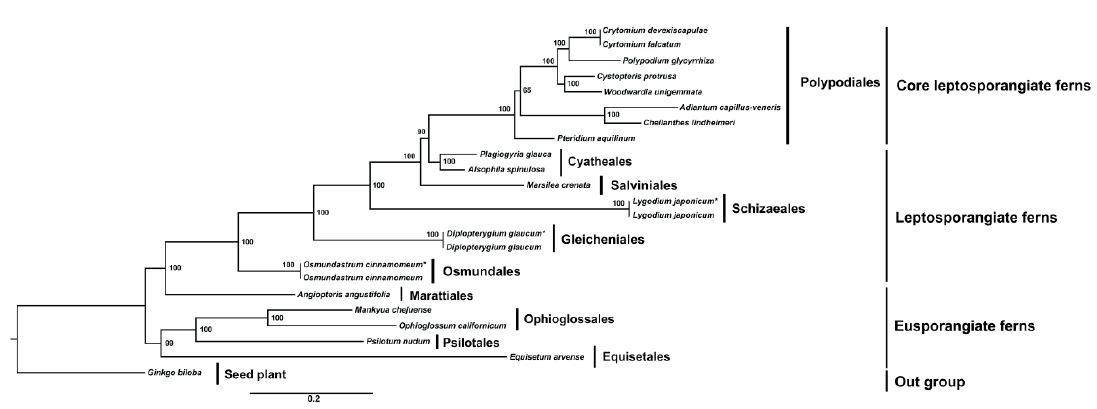
Figure 8. Molecular phylogenetic tree of 23 distinct fern taxa based on 76 protein-coding genes in the cp genome. The tree was constructed by maximum likelihood (ML) analysis of conserved regions using the Randomized Axelerated Maximum Likelihood (RAxML) program and the general time-reversible invariant-sites nucleotide substitution model. The stability of each tree node was tested by bootstrap analysis using 1000 replicates. Bootstrap values are indicated on each of the branches, whereas the branch length reflects the estimated number of substitutions per 1000 sites. The genus Ginkgo was set as the outgroup. * Fossil data cp genomes were used to identify phylogenetic relationships with corresponding taxa.